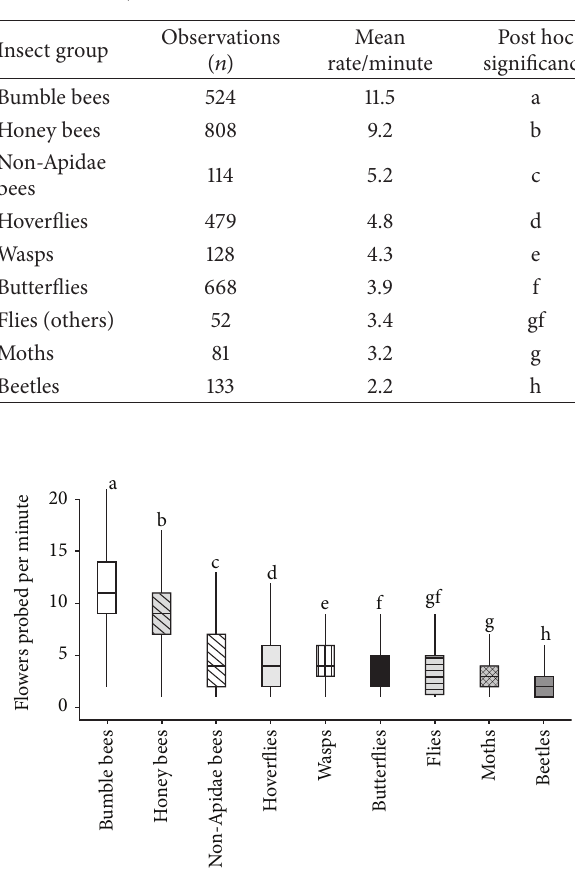
Table 1: Summary of rate data showing number of observations, the mean rate, and the post hoc significance. Rows are ordered according to visitation rate. In all, we collected rate data (flowers probed/minute) from 2987 insects.